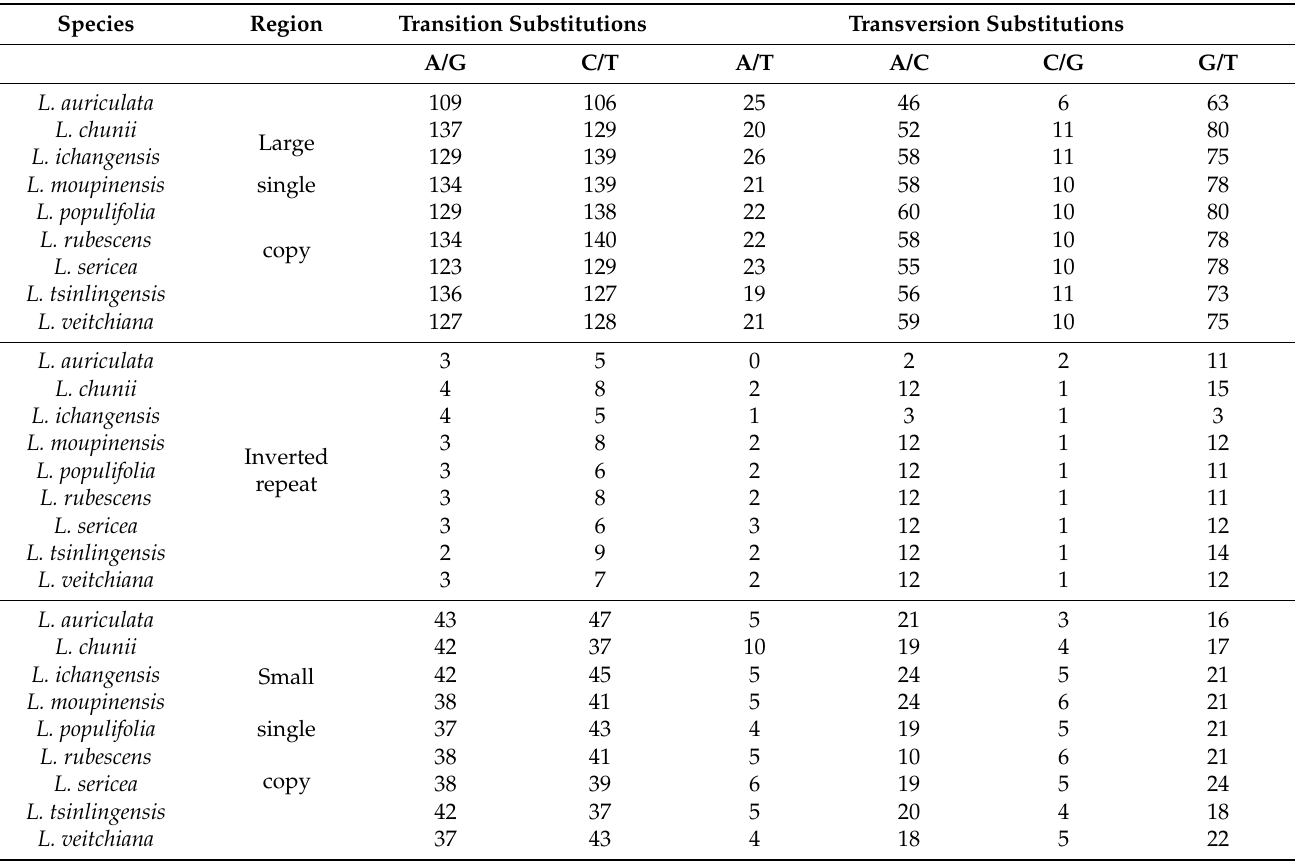
Table 3. The number of SNP types in LSC, IR and SSC regions of nine Litsea chloroplast genomes. Species